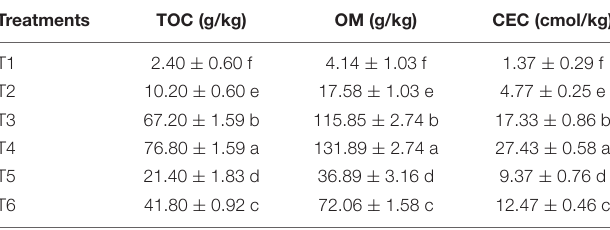
TABLE 4 | Effects of 1% HA addition on total organic carbon (TOC), organic matter (OM), and cation exchange capacity (CEC) of different substrates. Treatments